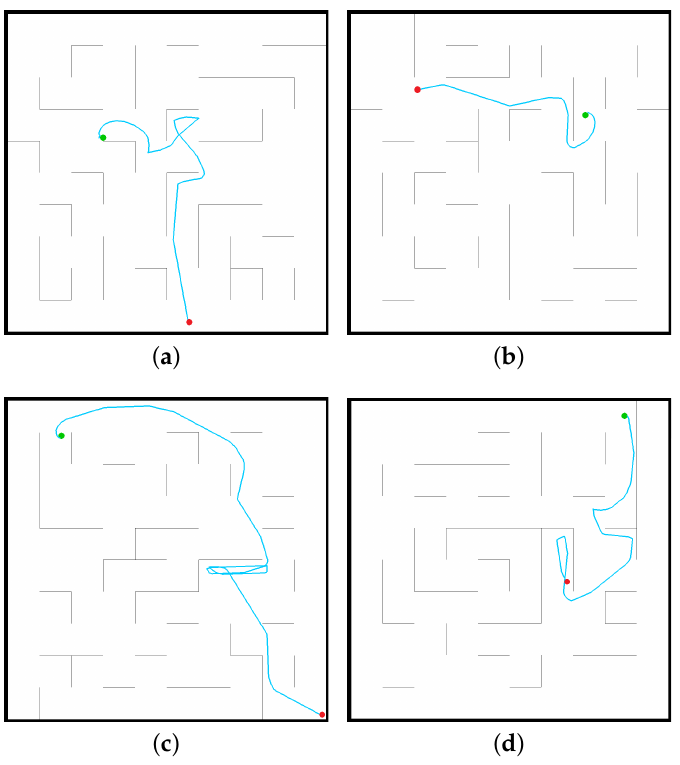
Figure 8. The paths of the mobile robot while performing navigation tasks using the trained neural network model in the simulator. ( a ) Case 1; ( b ) Case 2; ( c ) Case 3; ( d ) Case